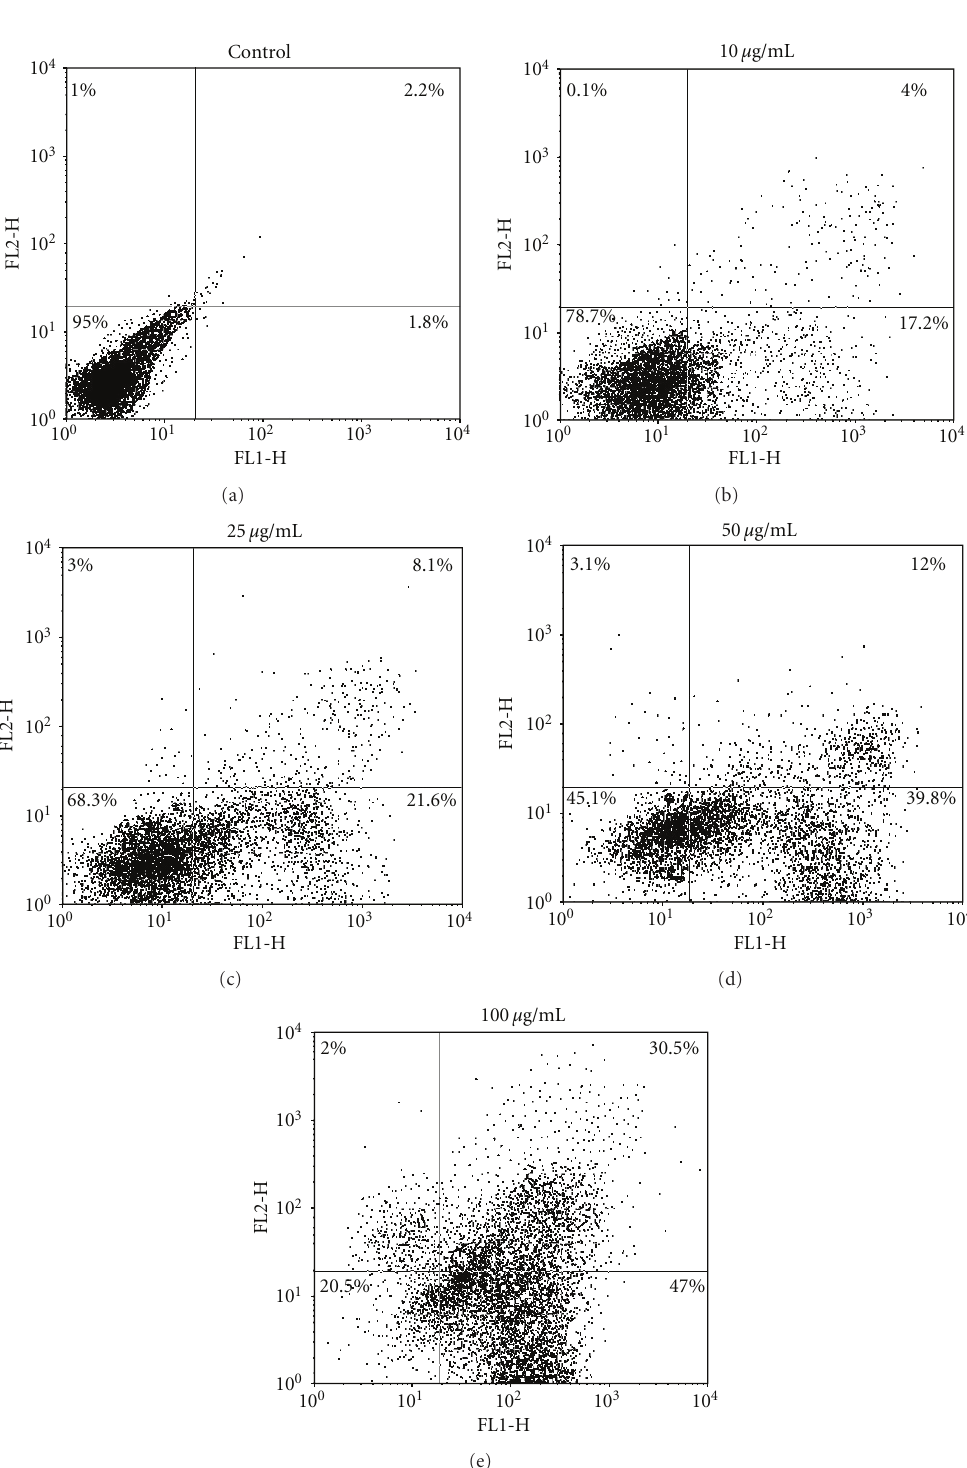
Figure 5: Induction of apoptosis in promastigotes of Leishmania infantum evaluated by flow cytometry method. (a) Most of promastigotes were alive and healthy (control group), (b) under 10 μ g/mL of antimony sulfide NPs, (c) under 25 μ g/mL of antimony sulfide NPs, (d) under 50 μ g/mL of antimony sulfide NPs, and (e) under 100 μ g/mL of antimony sulfide